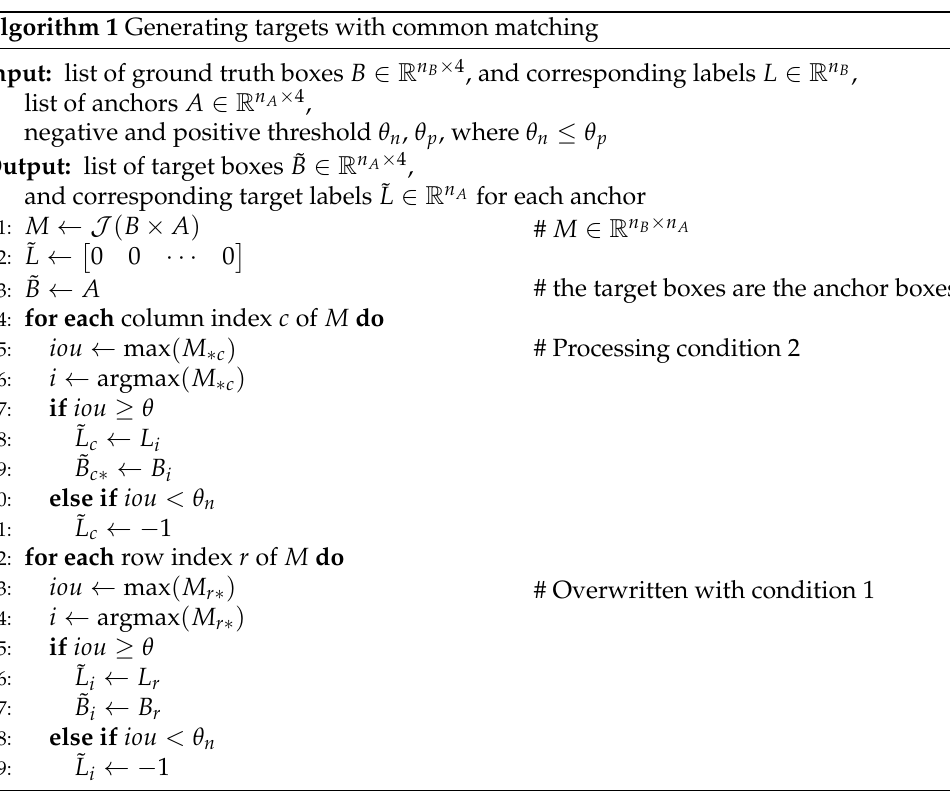
Algorithm 1 Generating targets with common matching